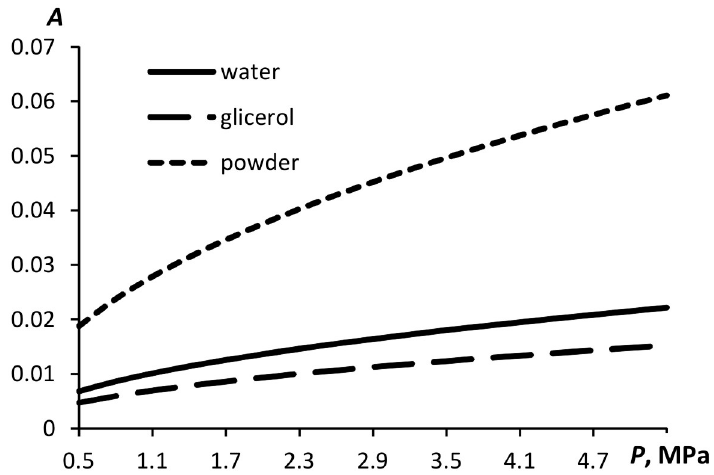
Figure 5. Relative displacement of the particles in a liquid as a function of pressure for water with a sound speed of c = 1481 m/s, glycerin with c = 1923 m/s, and powder with c = 60 m/s.